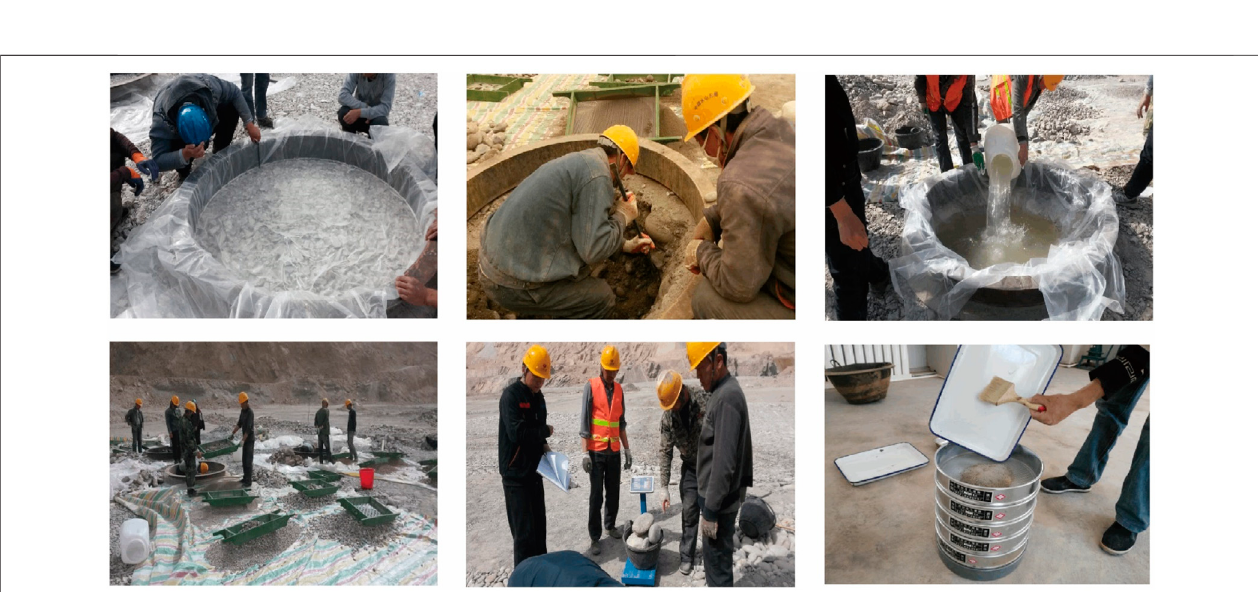
FIGURE 3 | Material source parameters and compaction density data